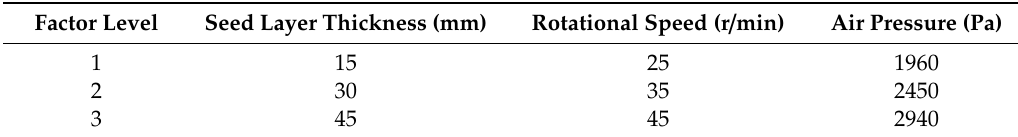
Table 1. Factors and levels of the orthogonal experiment.